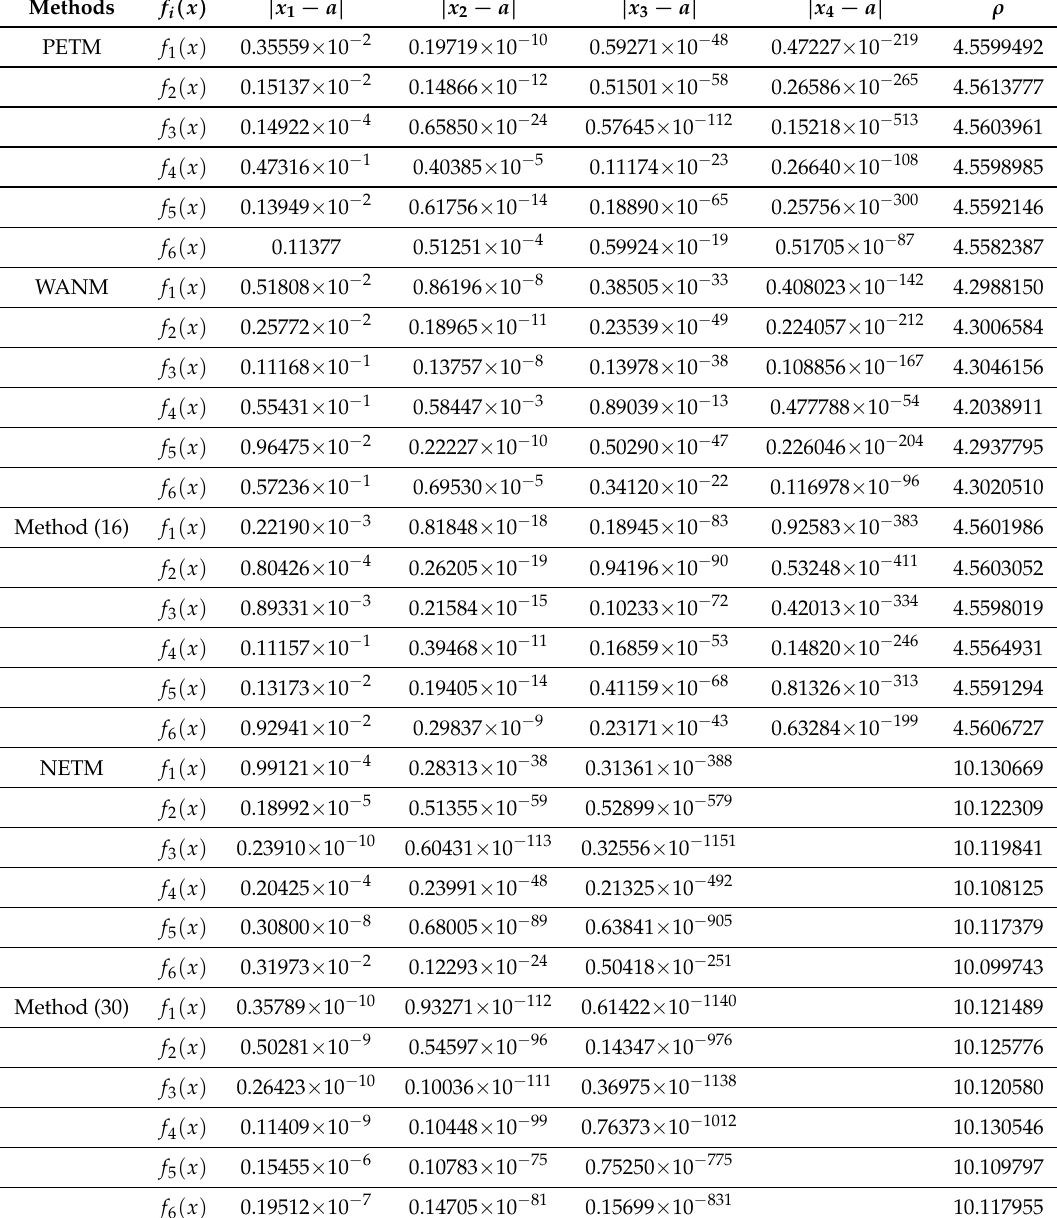
Table 1. Numerical results for f i ( x )( i = 1, · · · ,6 )